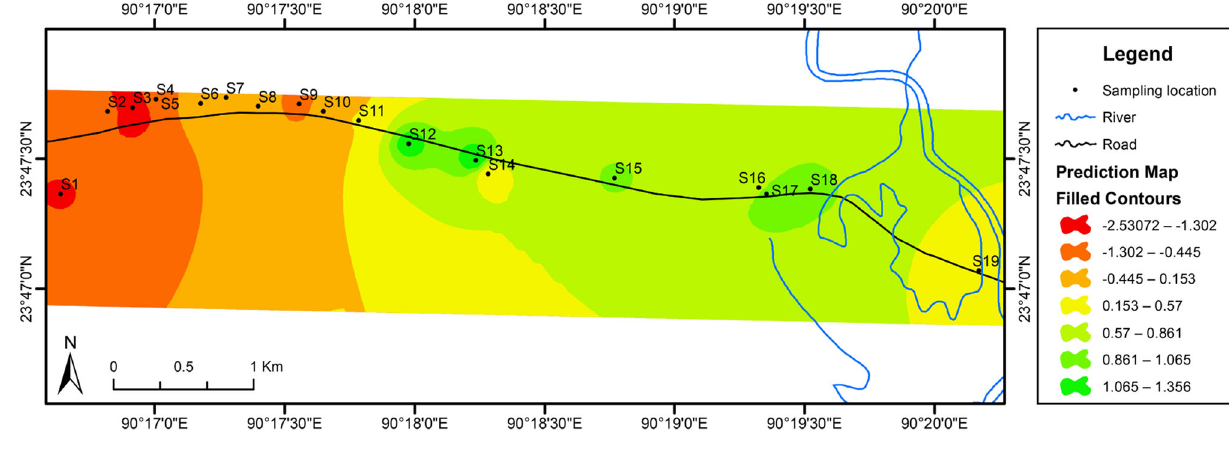
Fig. 4 Factor score map of principle component (PC1)